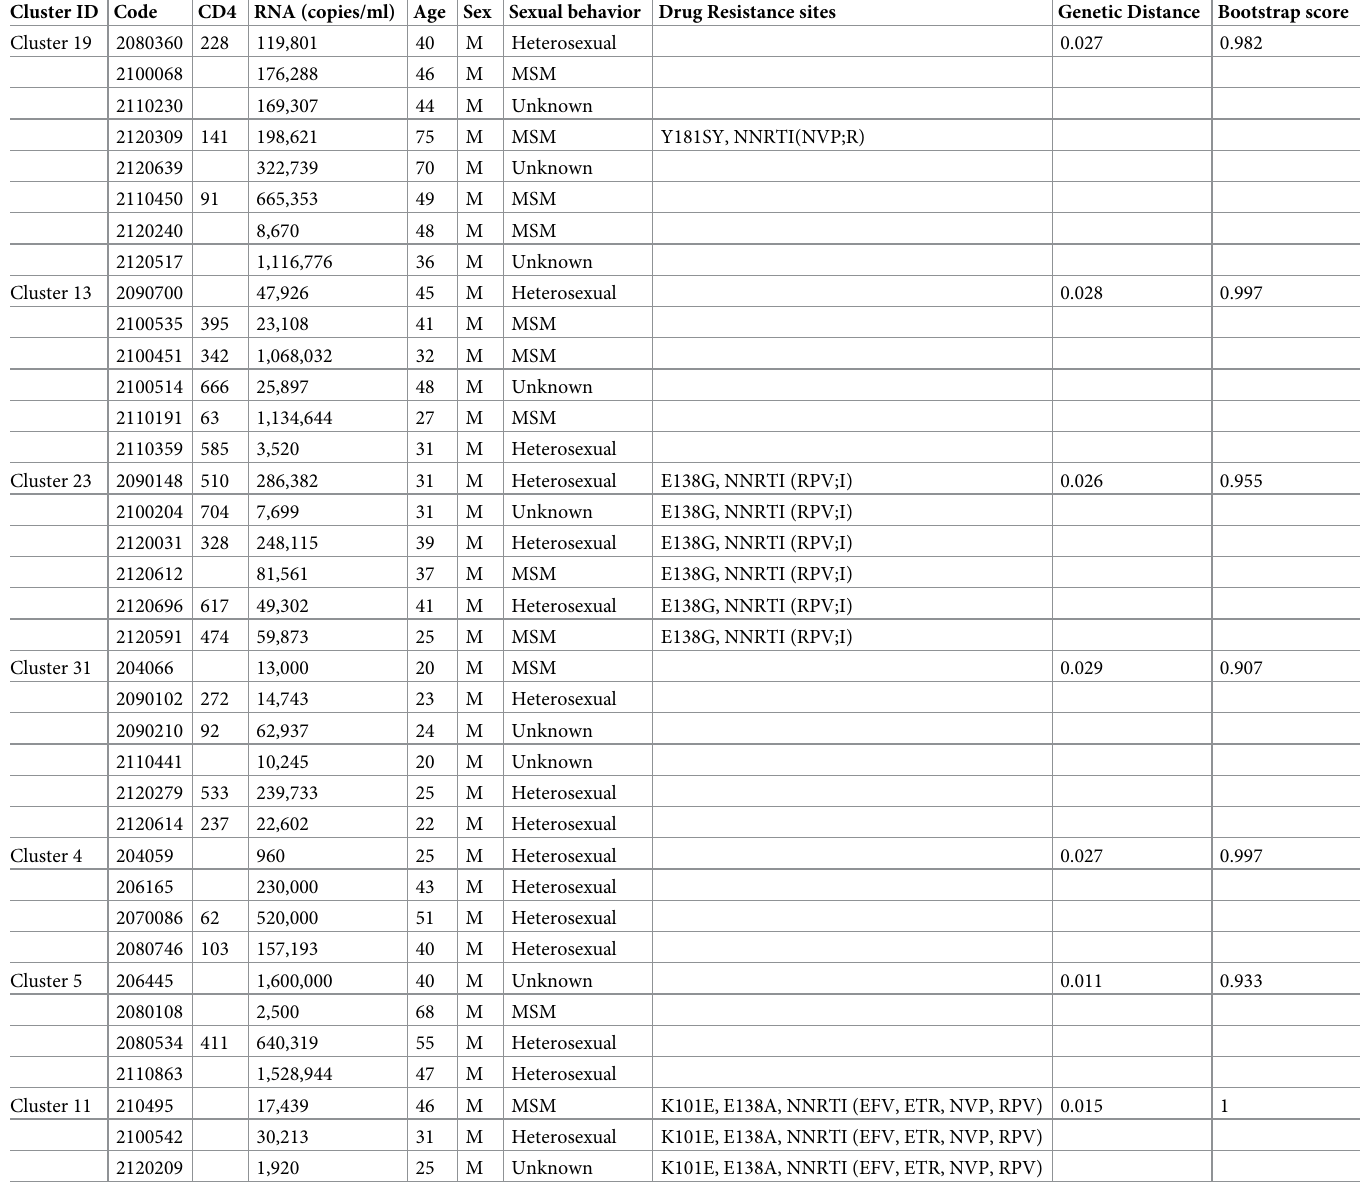
Table 4. Demographic and clinical characteristics of the transmission clusters in this study. Cluster ID Code CD4 RNA (copies/ml) Age Sex Sexual behavior Drug Resistance